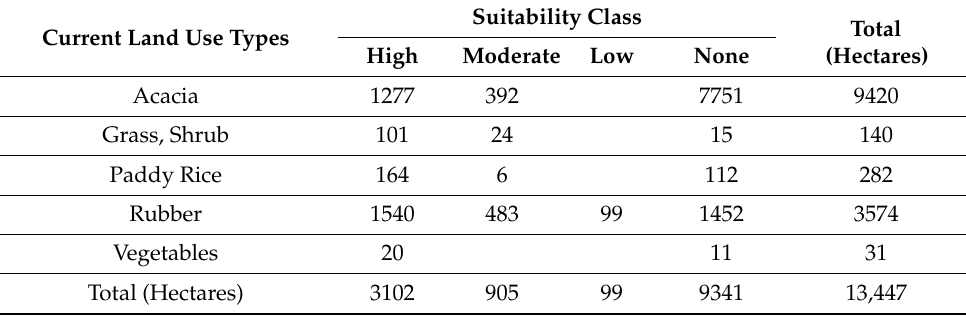
Table 9. The current land use and suitability class for acacia plantations.